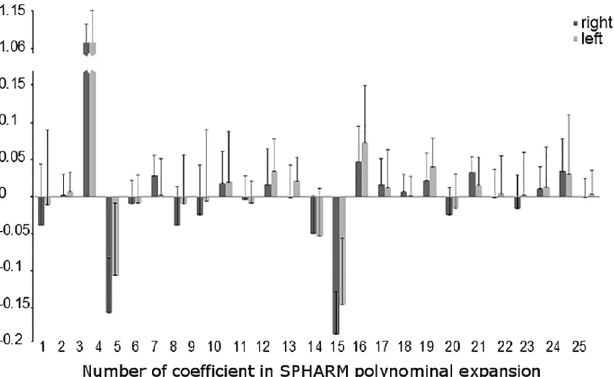
doi:10.1371/journal.pone.0134603.g004